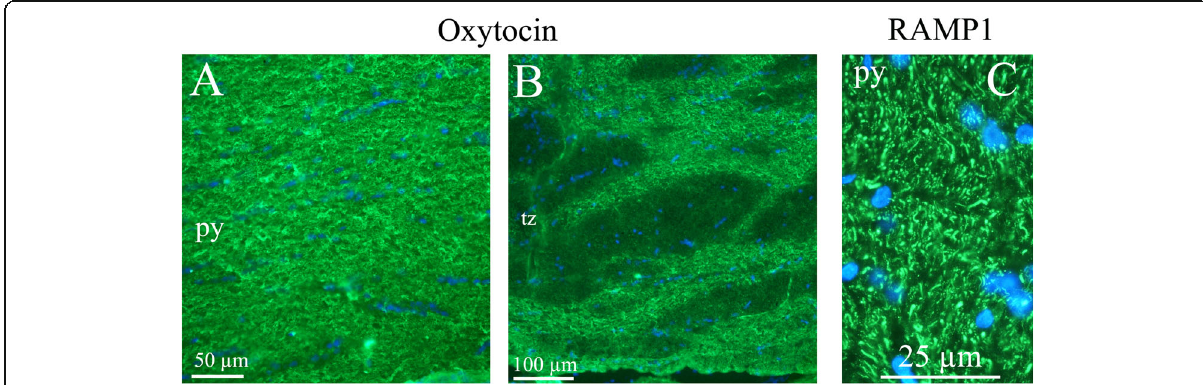
Fig. 9 Oxytocin immunohistochemistry of the pyramidal tract and the trapetzoid body. a and b . Oxytocin immunoreactive thin fibers were observed in the pyramidal tract (py) and the trapetzoid body (tz). c . In comparison, we have previously found RAMP1 immunohistochemistry displayed a pattern with both positive thick and thin fibers [25] (left image)